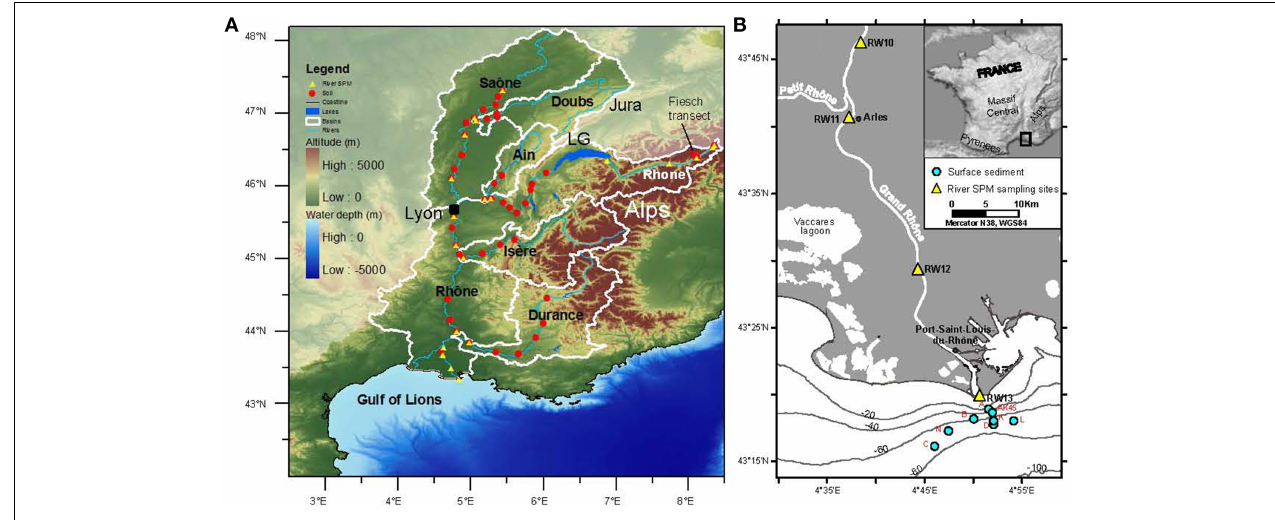
sediments (filled light blue dots) from the Rhône prodelta in the Gulf of Lions. The sampling locations of SPM (filled yellow triangles) collected near to theRhôneRivermoutharealsoshownin (B) .LGin (A) indicatesLakeGeneva.